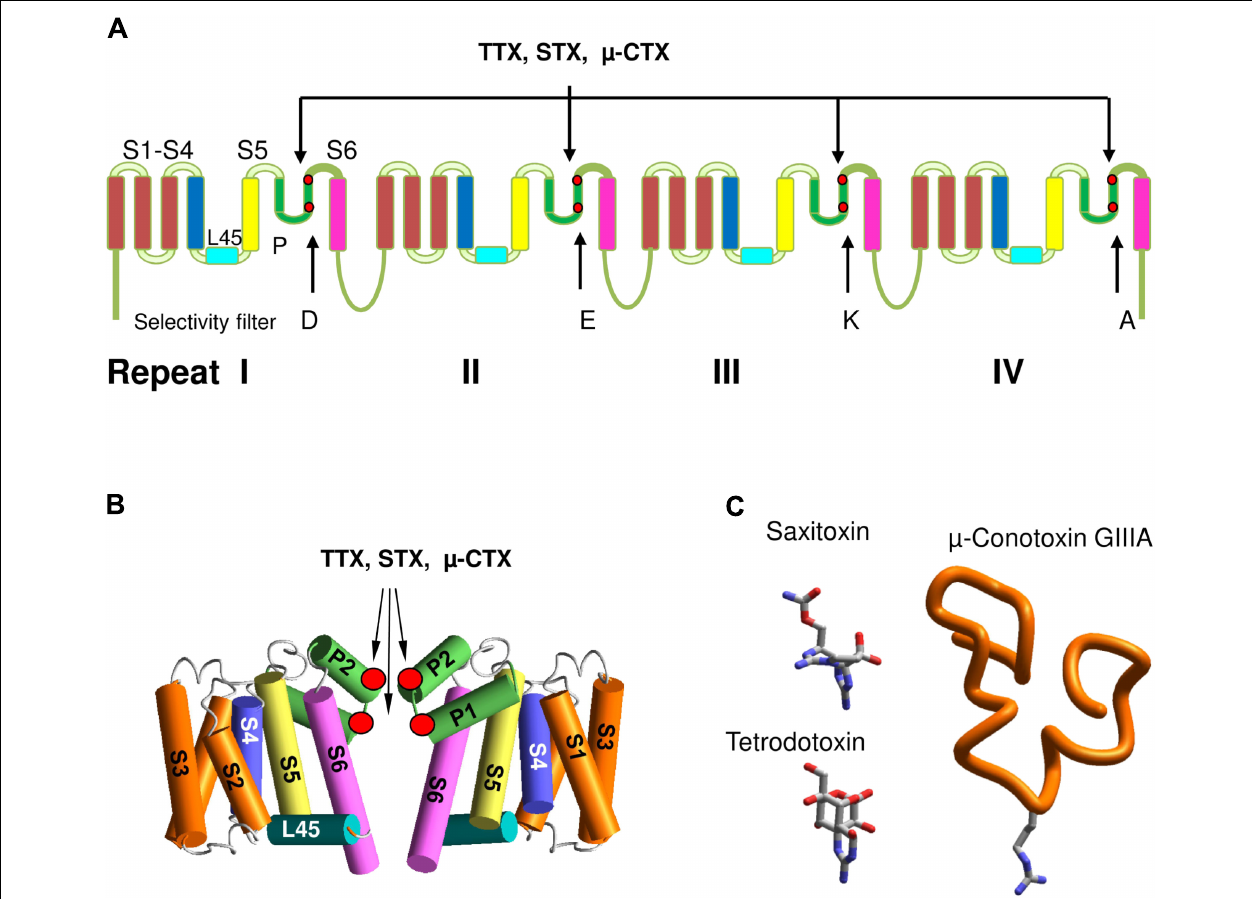
FIGURE 1 | Eukaryotic sodium channels and the outer pore blockers. (A) α -Subunit transmembrane topology. Positions of the selectivity filter DEKA residues and the outer carboxylates, which interact with TTX, STX and µ -CTX are marked by red dots. (B) General 3D model of sodium channels. Positions of toxin-interacting residues are shown by red circles. (C) 3D structures of the outer pore blocking toxins. Sown is Arg13 in GIIIA, which is critical for the channel